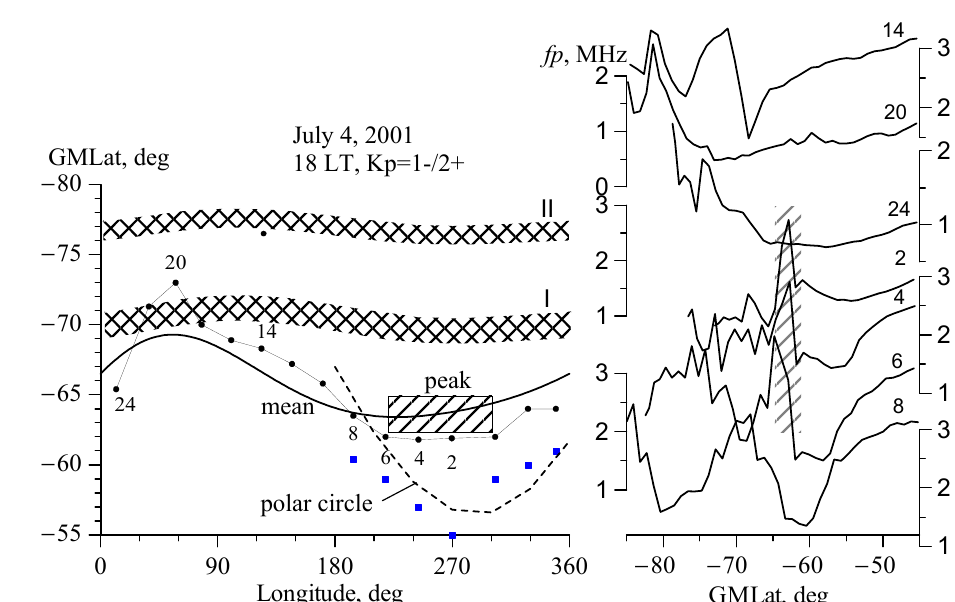
Figure 4. On the left : longitudinal variations on 4 July 2001 in the MIT position (black circles) and equatorward density minimum (blue squares). The average position of MIT (from Figure 1) is shown by a thick curve, and the polar circle is a dashed curve. Hatching shows the position of both zones of precipitation and the plasma density peak. On the right : fp latitudinal cross-sections for the paths indicated on the left.